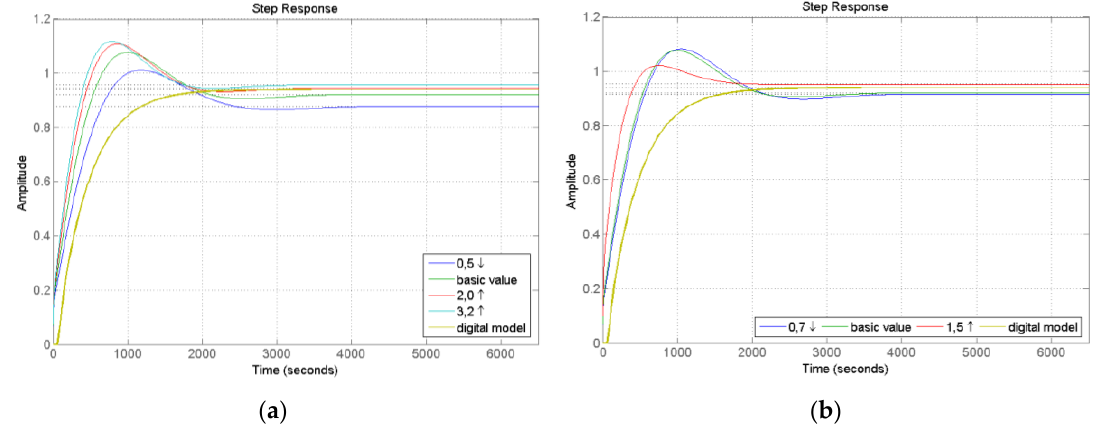
Figure 9. Segment G2 step responses for simulation of changes in working medium flow rate ( a ) and